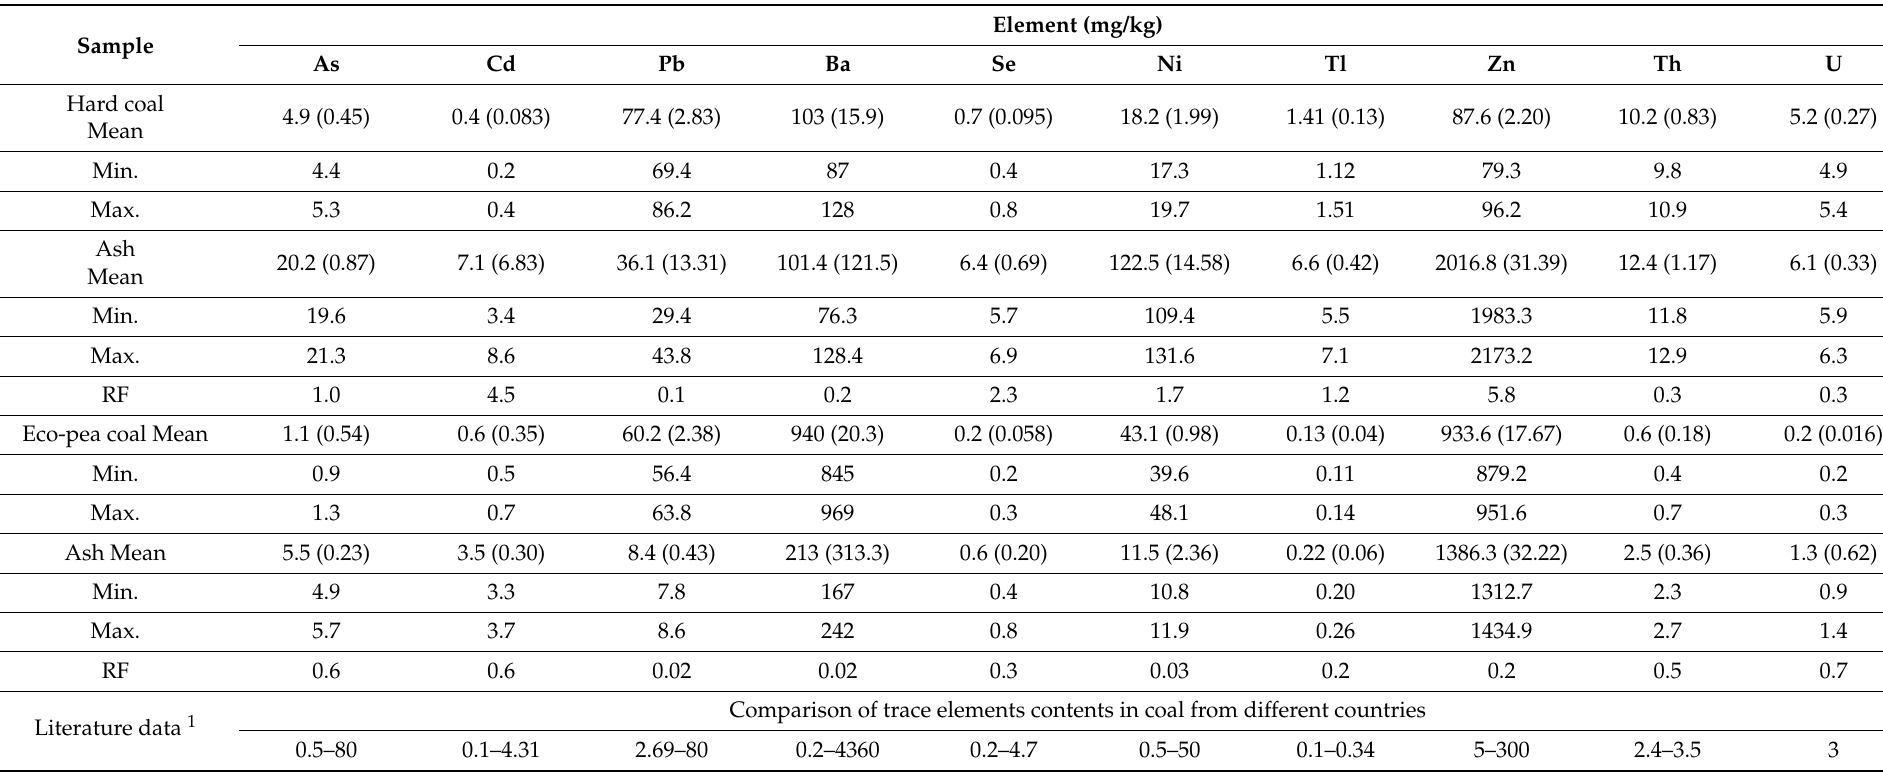
Table 3. Average content of PTE in coal and ashes from individual household furnaces in Pszczyna—Piasek (standard deviation, SD, presented in brackets; RF—relative enrichment factor).